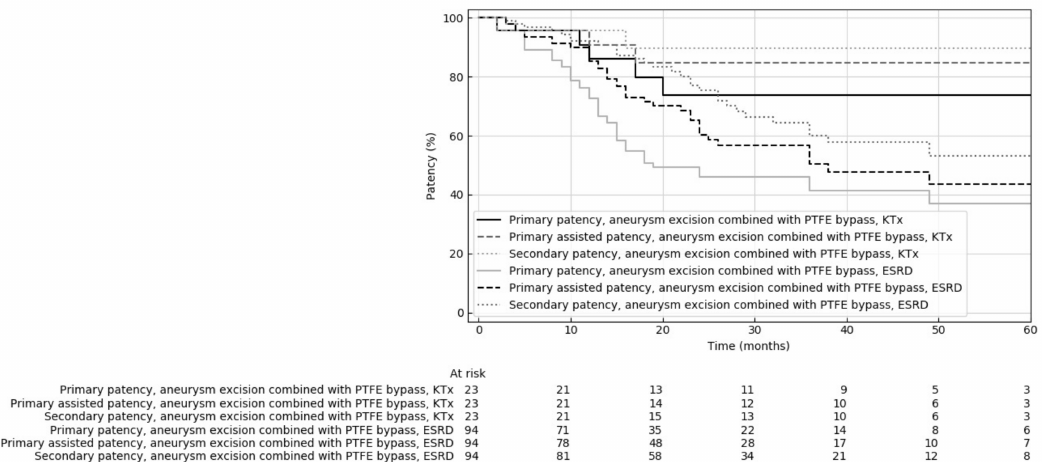
Figure 2. Comparison of primary, primary assisted and secondary patency rates of dialysis fistulas reconstructed by fistula aneurysm combined with PTFE bypass graft in kidney transplant patients (KTx) and dialyzed patients with end-stage renal insufficiency